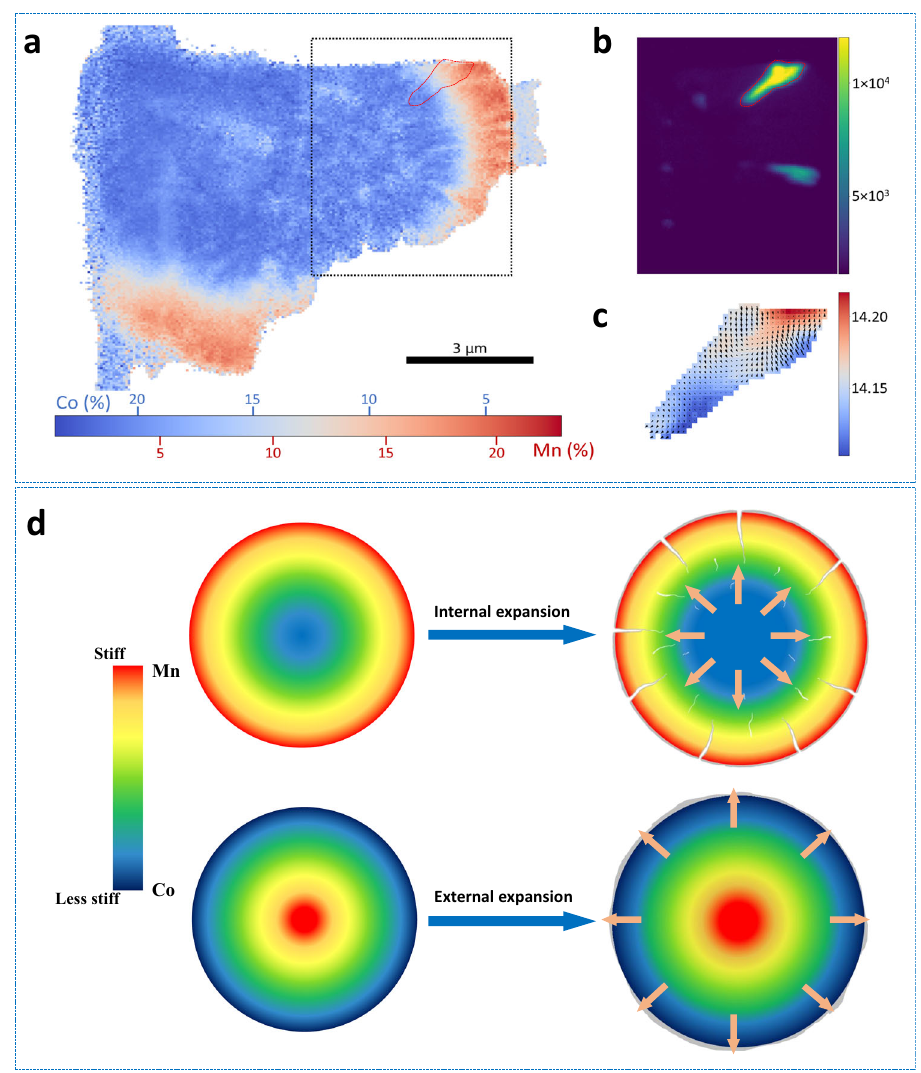
Fig. 7 Nanoscale structure variation within concentration gradient cathodes and the relationship between concentration designs and mechanical properties. a Spatial element distributions of Mn (red) and Co (blue) in NC-NM82 sample, detected by X-ray fl uorescence. The color bar refers to the concentration of Co and Mn. b X-ray nanodiffraction image of NC-NM82 sample. The color bar refers to the diffraction intensity. c Detailed analysis of nanodiffraction in the selected primary particle. The color bar refers to the lattice parameters. d The mechanism schematic of two different concentration gradient designs and their mechanical